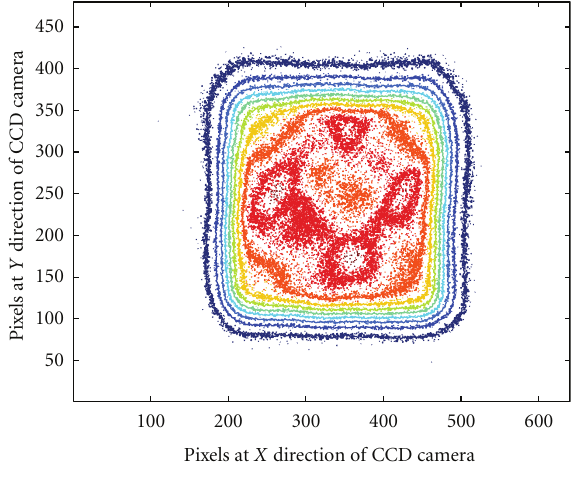
Figure 9: The contour of concentration spot.